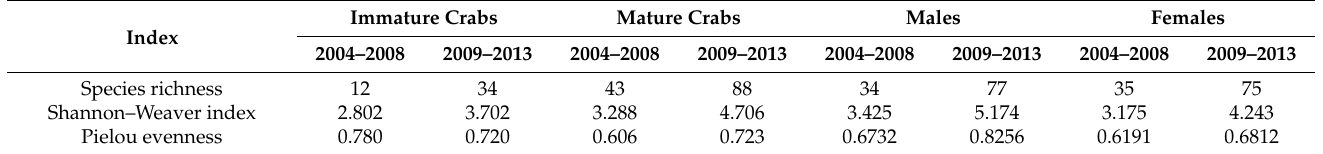
Table 3. Diversity indices of fauna associated with red king crabs in the coastal Barents Sea.